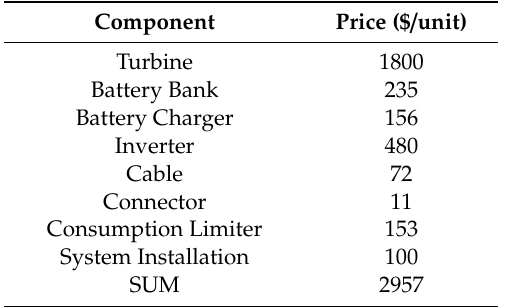
Table 2. Cost table for hydrokinetic turbine power